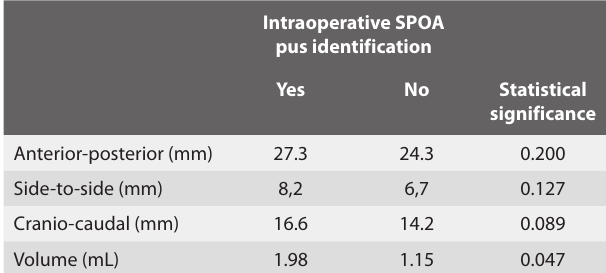
Table 2. Mean dimensions of subperiosteal abscesses in the 24 CECT scanned patients measured from preoperative scans.